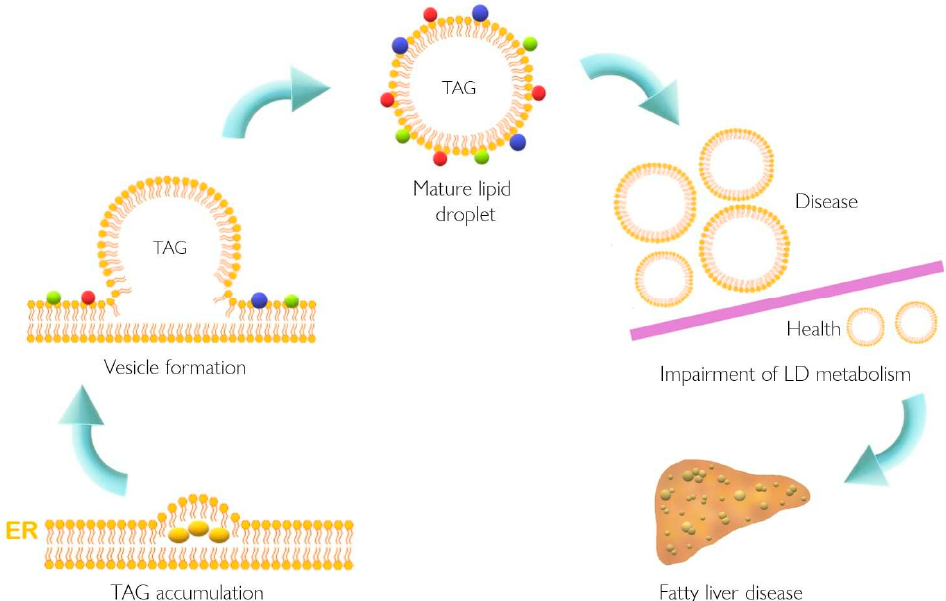
Figure 1. Lipid droplet formation and excessive accumulation leads to hepatic pathological conditions. TAG accumulation in the ER membrane, accompanied by the action of different proteins, leads to LD formation. This excessive accumulation results in impairment in storage of LD in several tissues resulting in pathological conditions such as non-alcoholic fatty liver disease. Colorful spheres around LD represent perilipins, Rab proteins, and Arf-COPI proteins. ER, endoplasmic reticulum; LD, lipid droplet; TAG, triacylglyceride.